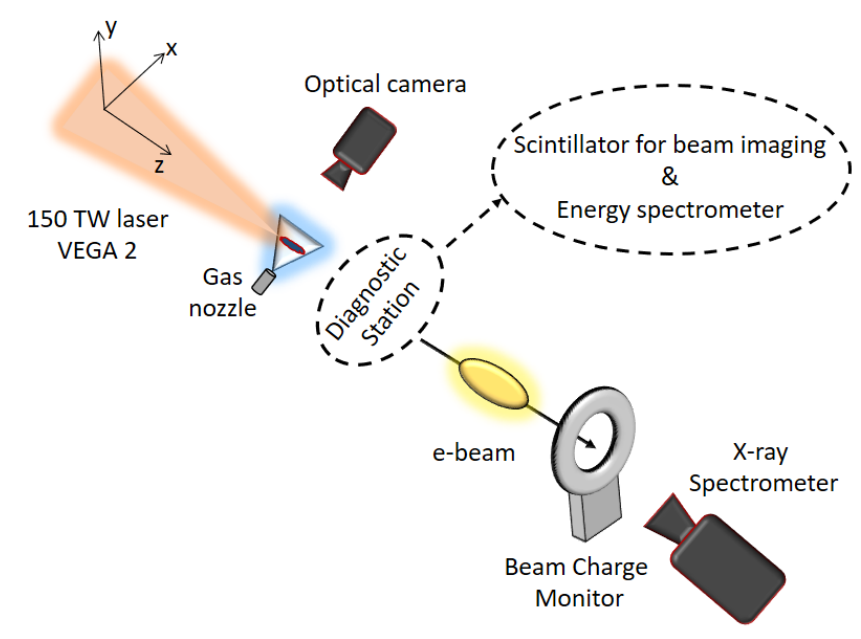
Figure 2. Experimental setup (X-rays detected after deflecting the electrons into the